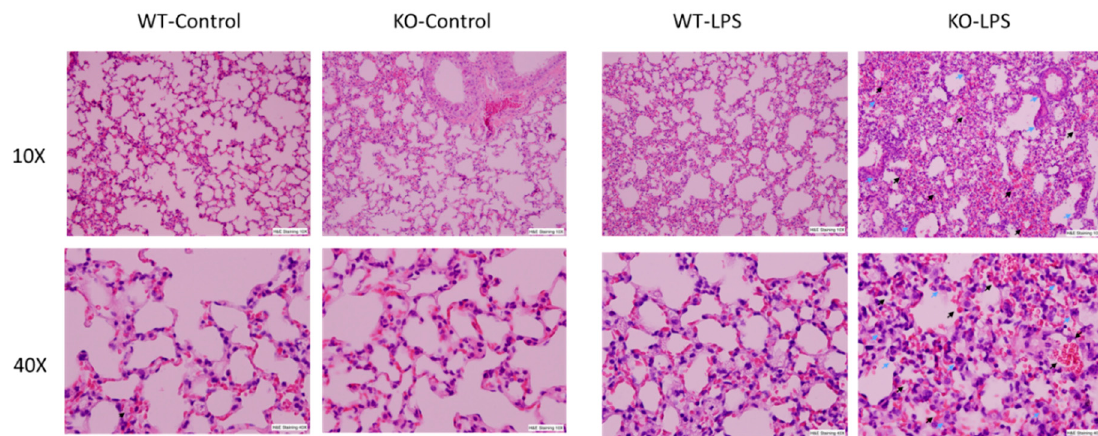
Figure 1. LPS-induced more severe lung pathological alterations in RNase L deficient mice compared to wild type mice. Age-matched male RNase L wild type and deficient mice (6/group) received intranasal instillation of LPS for 24 h. Histological changes in the lung structures after LPS inhalation are shown. Representative images of hematoxylin and eosin stained sections of lung tissues are present at 10× and 40× magnifications. Pneumocytes (indicated by blue arrows) and hemorrhage (indicated by black arrows).